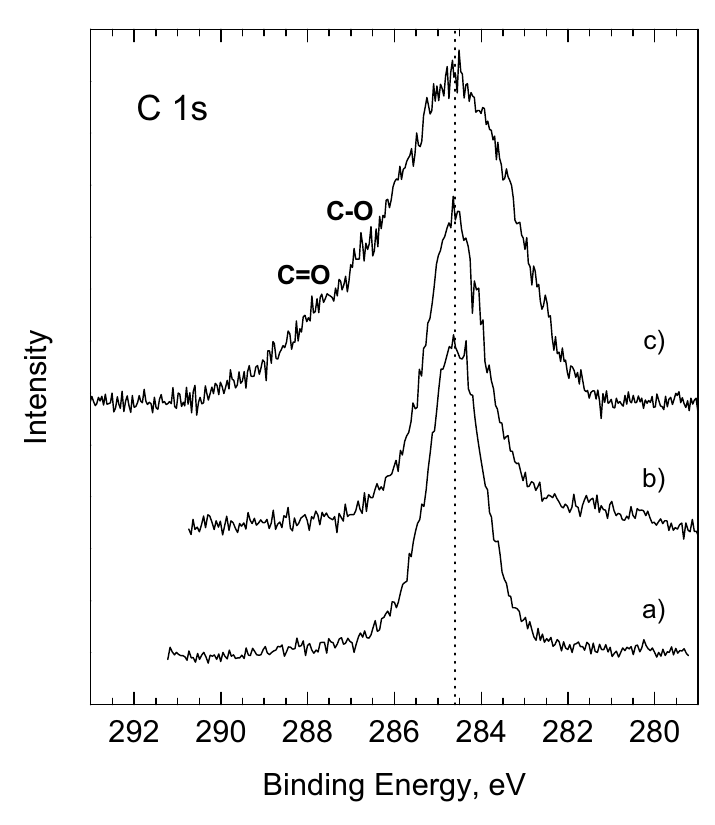
Fig. 8 The XPS C 1s core level of ODA-clinoptilolite with adsorbed chromate (a) and arsenate (b), and of carbonized clinoptilolite